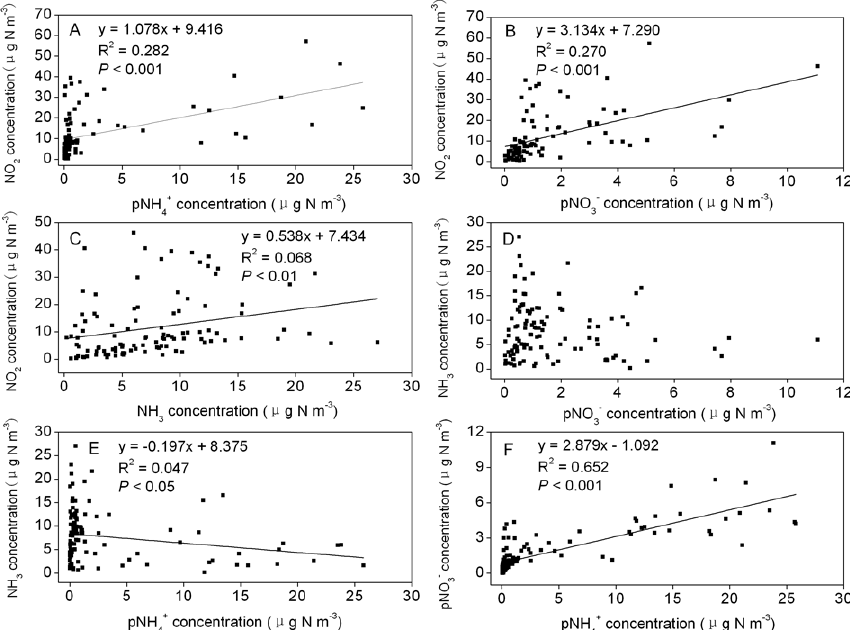
Fig. 5. Correlations among NO 2 , NH 3 , p NO − (D) NH 3 vs. p NO −